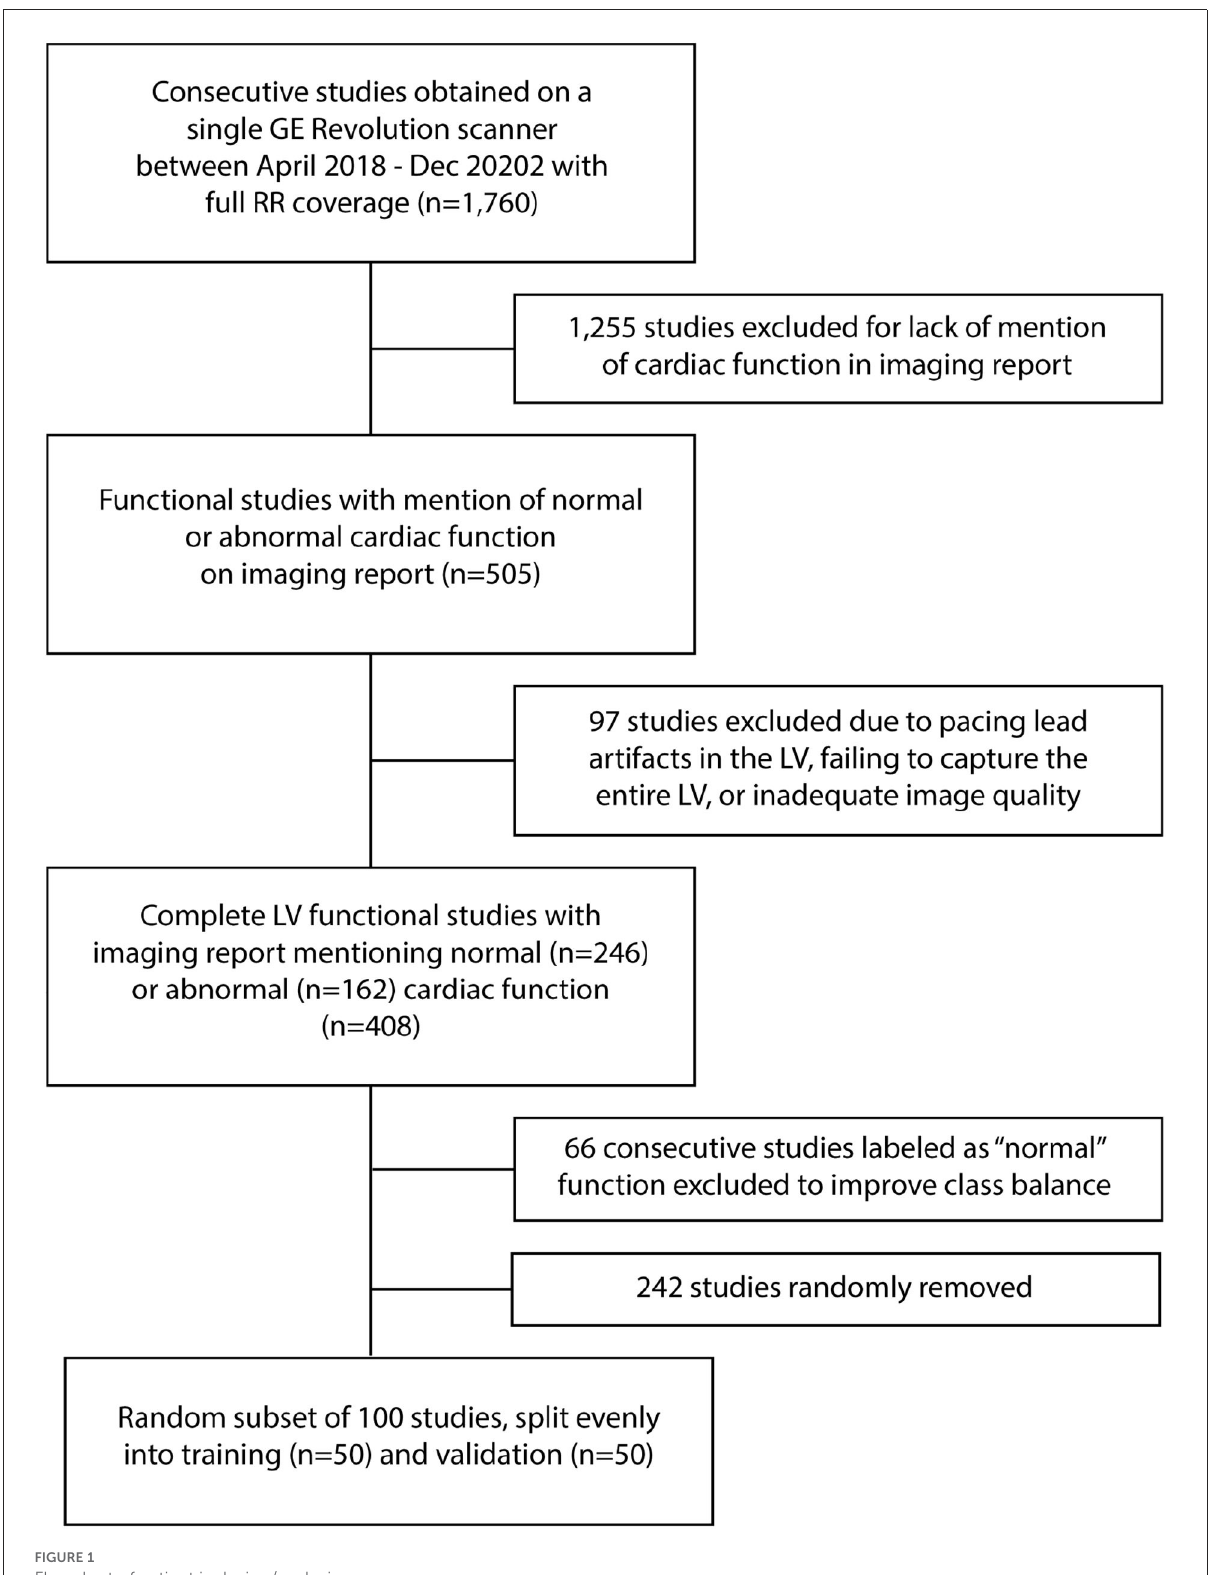
FIGURE1 Flowchart of patient